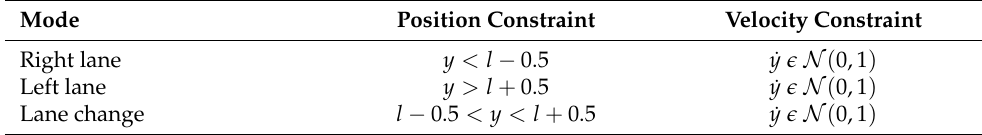
Table 3. Constraints for lateral maneuvers.